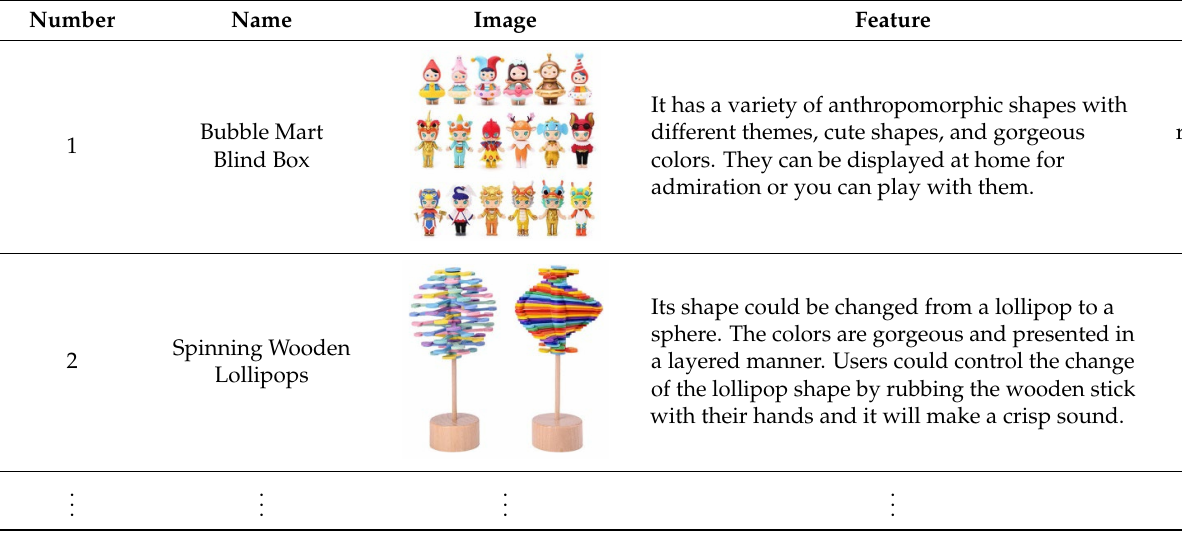
Figure 2. 100 images of healing commodities (P1–P100). Table 4. Information table about healing